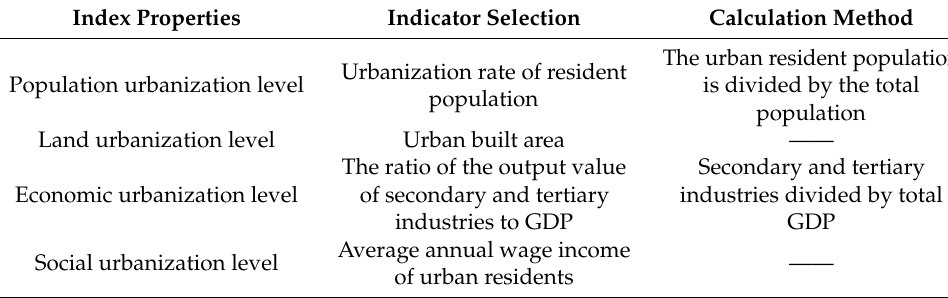
Table 3. Indicator system for the judgment of urbanization